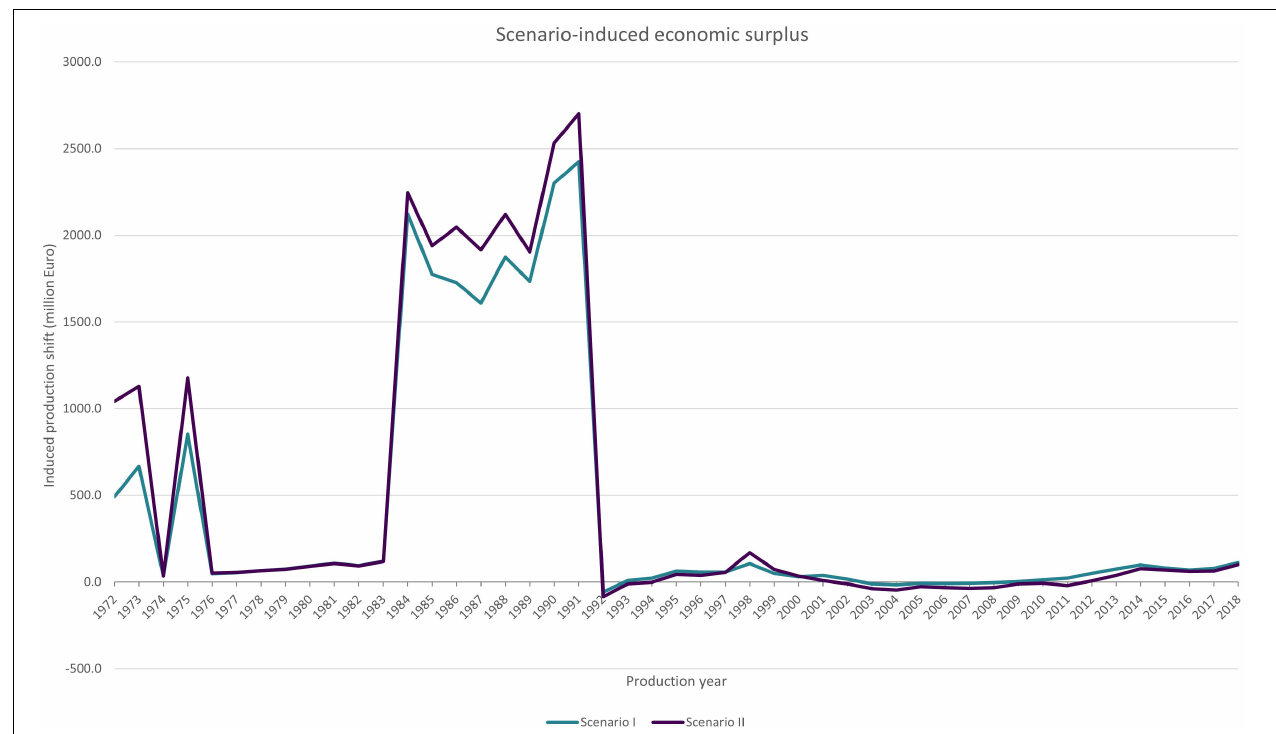
FIGURE 3 | Economic surplus attributed to exchanging parental material in the winter wheat breeding process. Source: Authors’